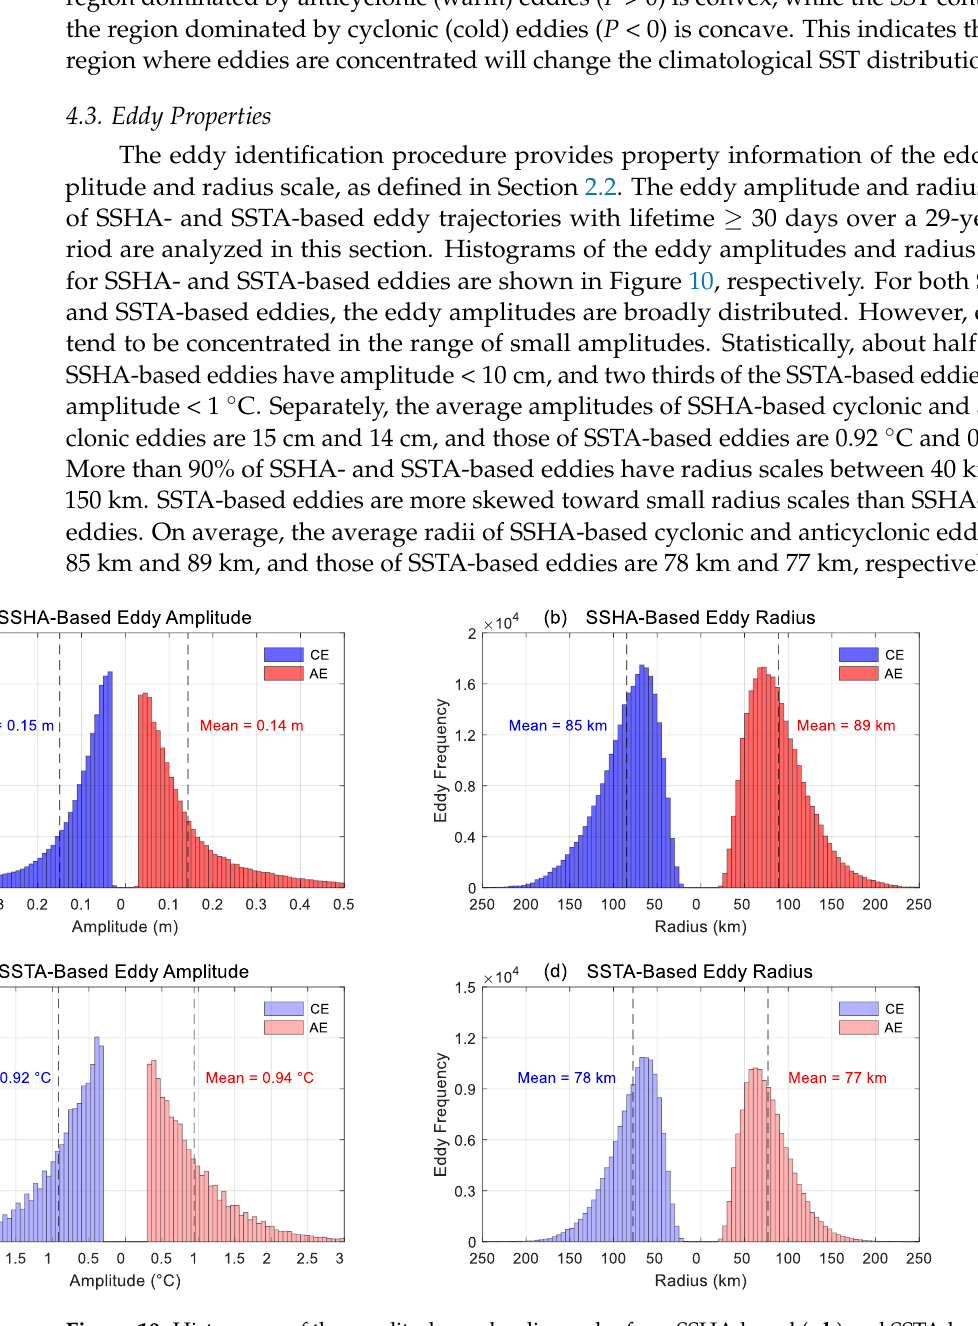
Figure 10. Histograms of the amplitudes and radius scales from SSHA-based ( a , b ) and SSTA-based ( c , d ) eddy trajectories with lifetime ≥ 30 days for cyclonic (CE) and anticyclonic (AE) eddies. The dotted line represents the average value of eddy